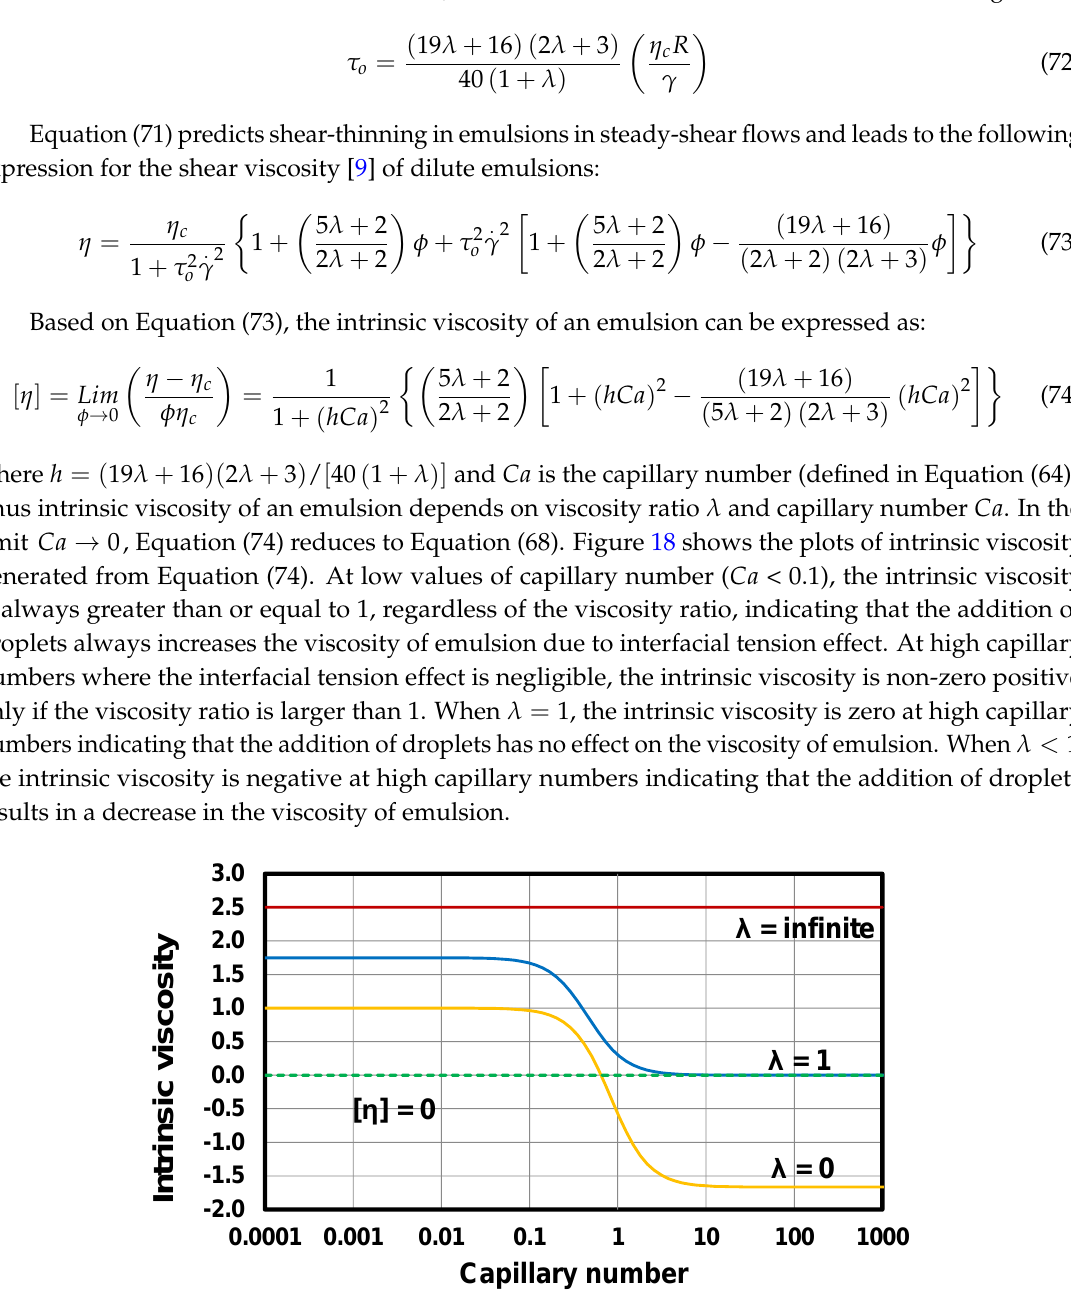
Figure 18. Intrinsic viscosity of emulsion as a function of capillary number for different values of viscosity ratio λ